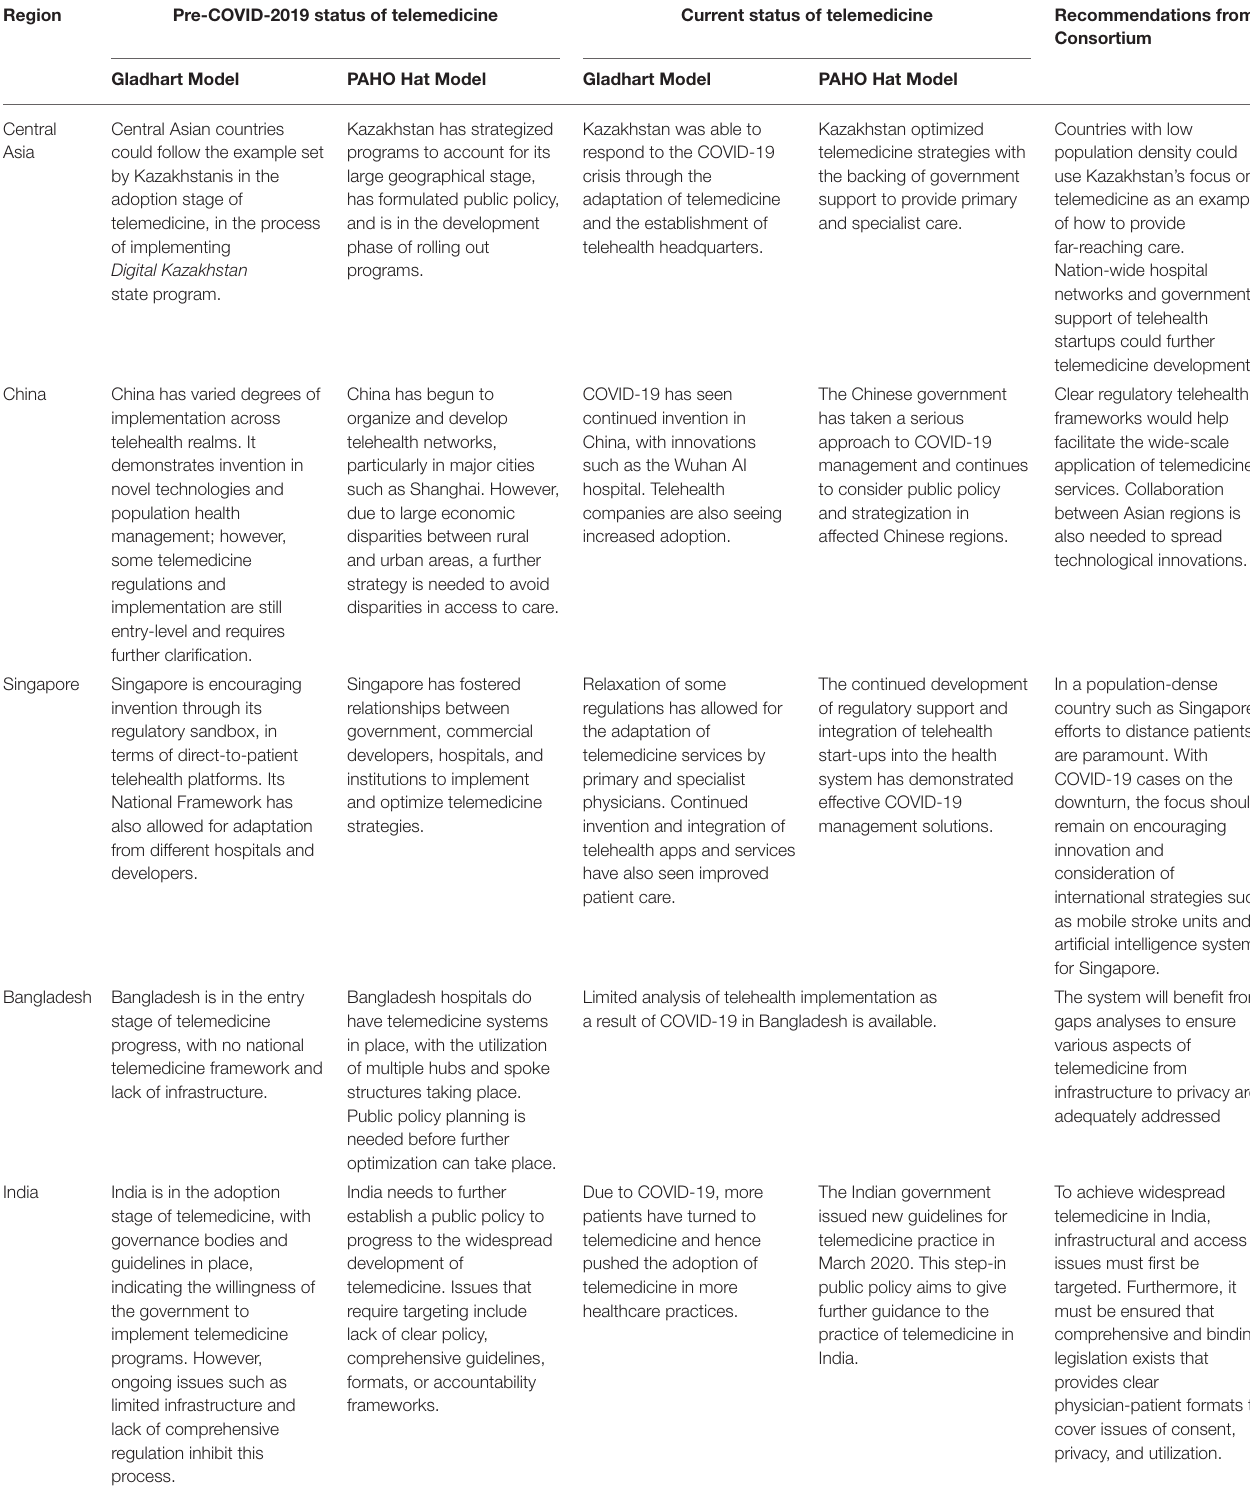
TABLE 1 | Status of telemedicine in different geographical regions and recommendations from the Consortium.